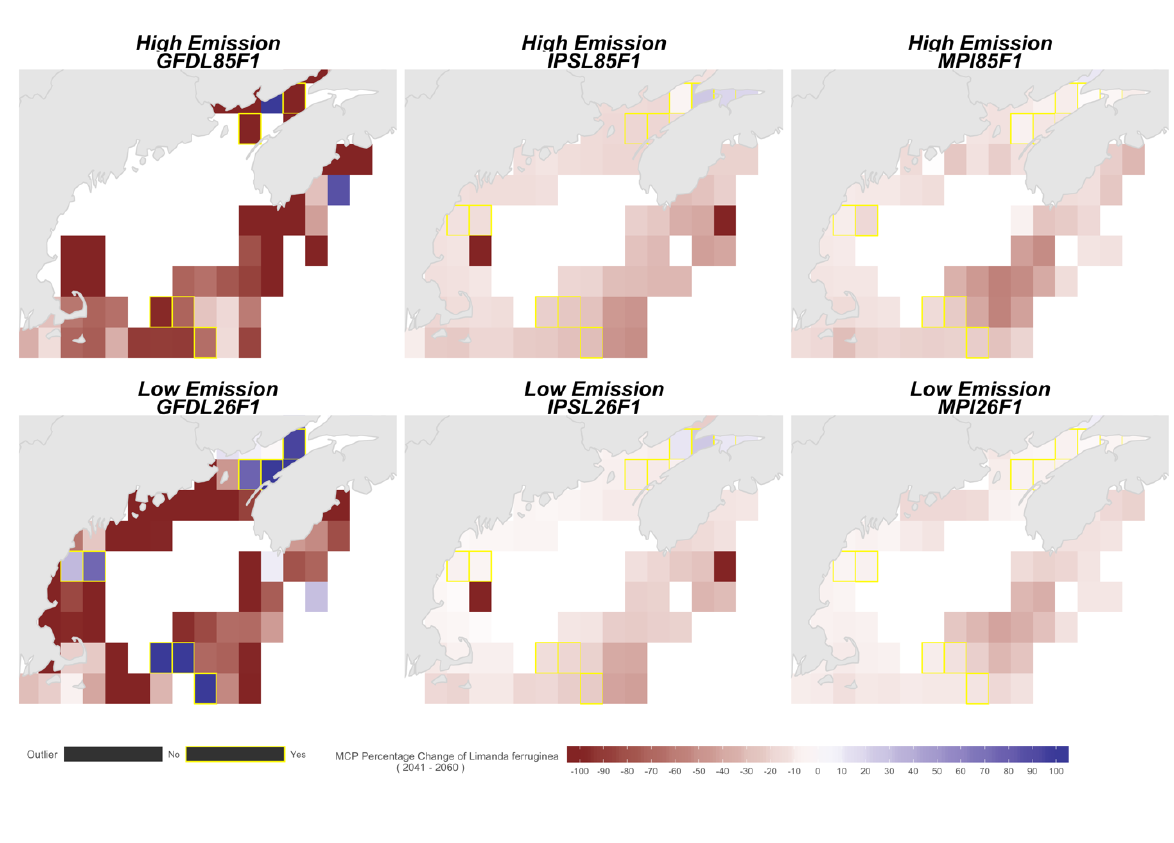
Fig A2.3. Changes in maximum catch potential of yellowtail flounder ( Limanda ferruginea ) within the study area by mid-century relative to present time. Results for the three global circulation models (GFDL, IPSL, MPIS) used in the current study and two climate change scenarios (Top: High emission – RCP 8.5, Bottom: Low Emission – RCP 2.6). Grid-cells marked in yellow represent discrete areas where average MCP is projected to increase by